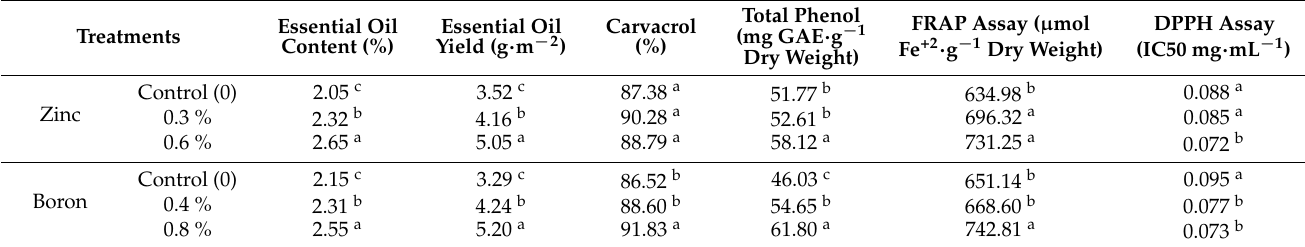
Table 6. Mean comparison of the simple effects of boron and zinc foliar application on phytochemichal traits of S. khuzistanica in the first year of the